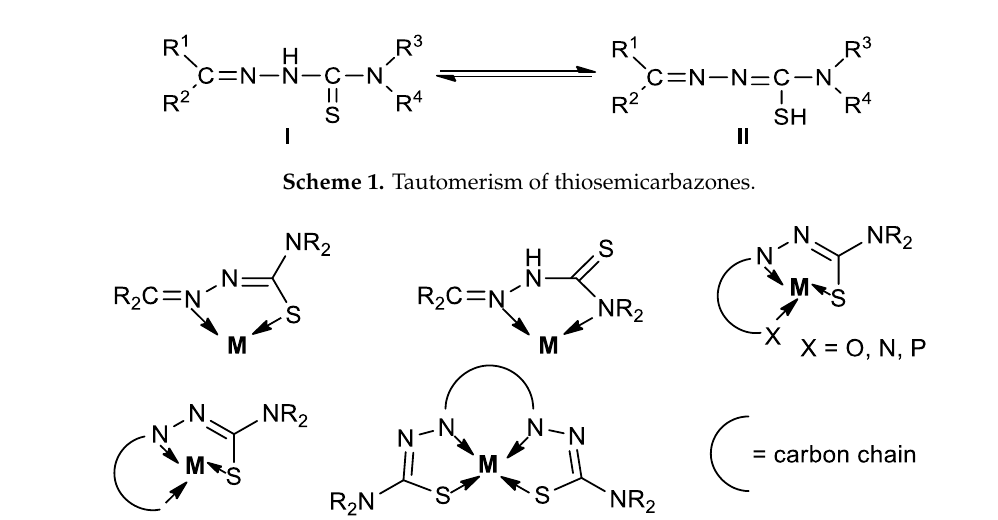
Scheme 2. Representative coordination modes of thiosemicarbazones.